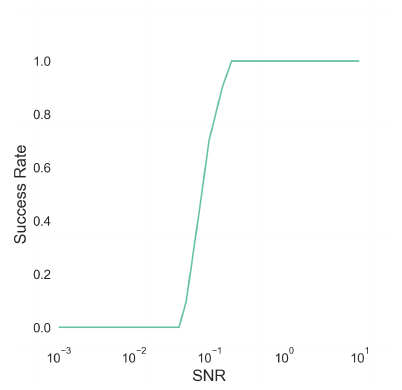
Figure 6: Success Rate of Step 1 with 256 traces as function of the